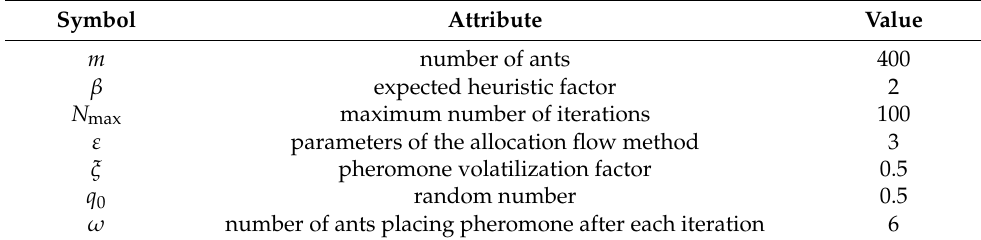
Table 3. Parameters of the IACS.